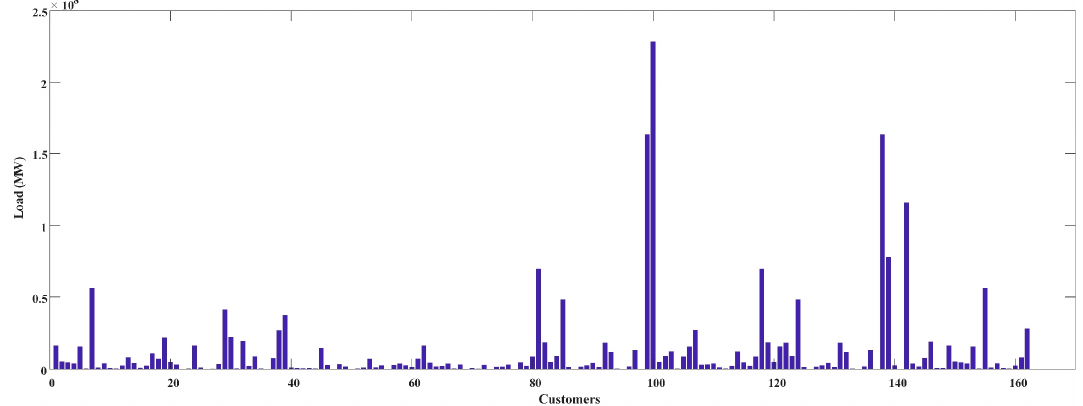
Figure 3. The annual power consumption of each customer.